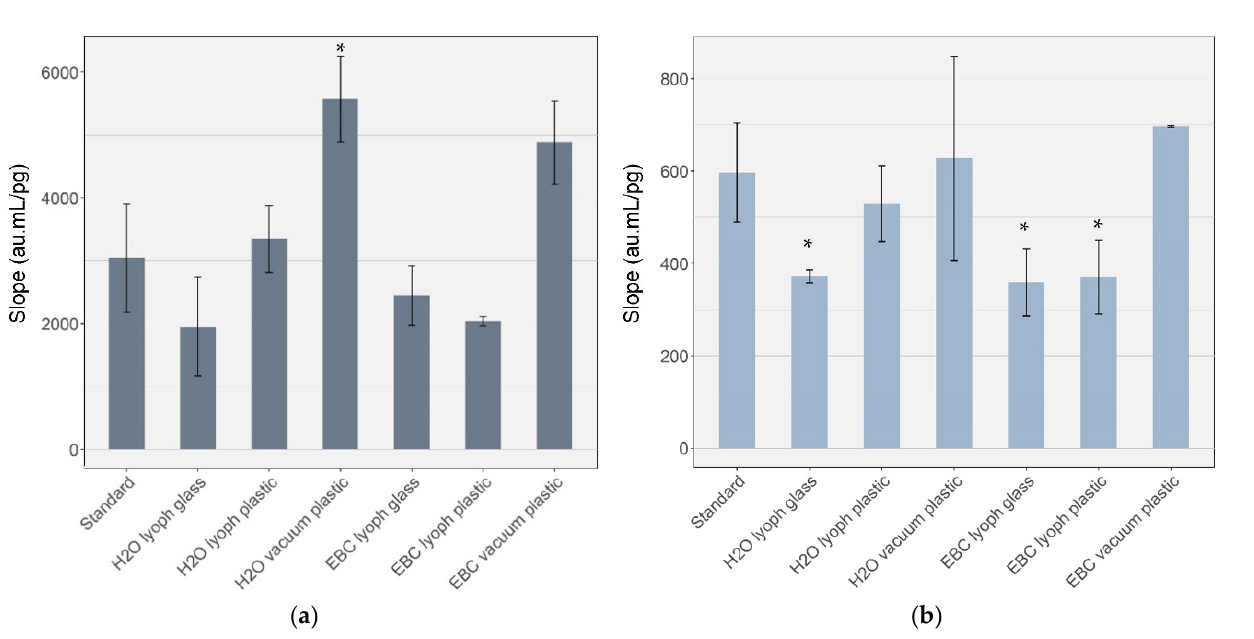
Figure 2. Slope signal (not corrected with IS) of the calibrations (minimum of 5 levels) obtained with water and EBC after lyophilization (lyoph) or vacuum concentration, in comparison with standard solutions without any concentration step for the biomarker ( a ) 8-OHdG and ( b ) 8-isoprostane, respectively. Error bars correspond to a minimum of two independent repetitions. au= Arbitrary unit; lyoph = lyophilization; standard = non-concentrated standard; H 2 O lyoph = concentrated standard.* Statistically significant difference ( p < 0.05) compared to the standard without the concentration.